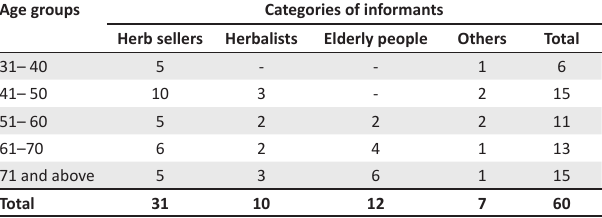
TABLE 1: Distribution of local informants in accordance with their age groups.